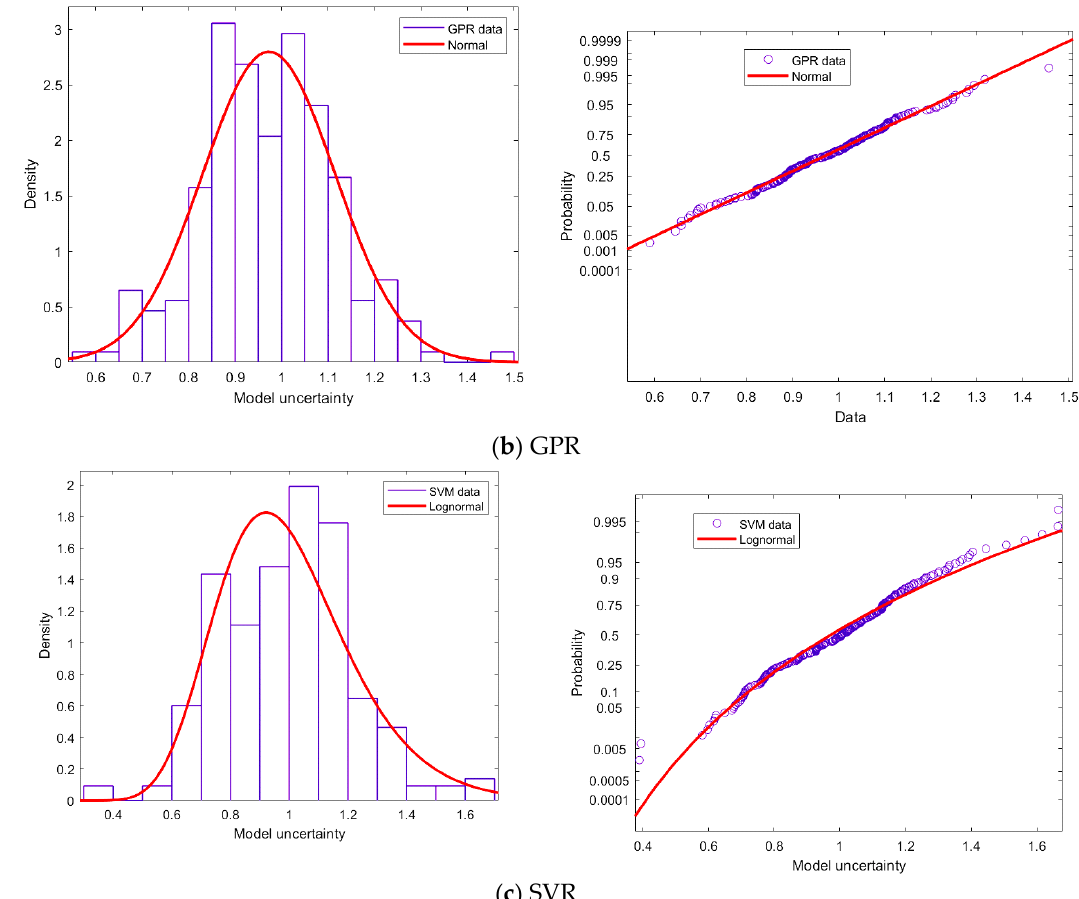
Figure 9. Model uncertainty distribution plots, experimental frequency histogram and probability plots. ( a ) CCD; ( b ) GPR; ( c ) SVR.